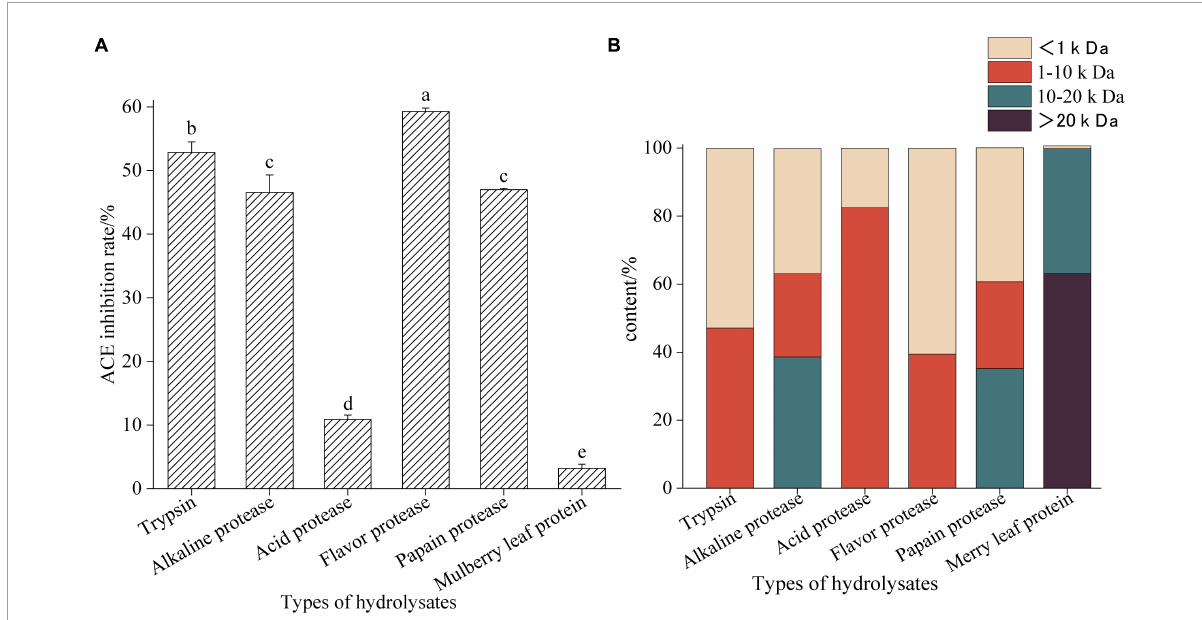
FIGURE1 Angiotensin-I converting enzyme inhibition activities of mulberry leaf protein hydrolysates hydrolyzed by different proteases (A) and molecular weight distribution (B) . Means denoted by a different letter indicate significant differences between treatments ( P < 0.05).